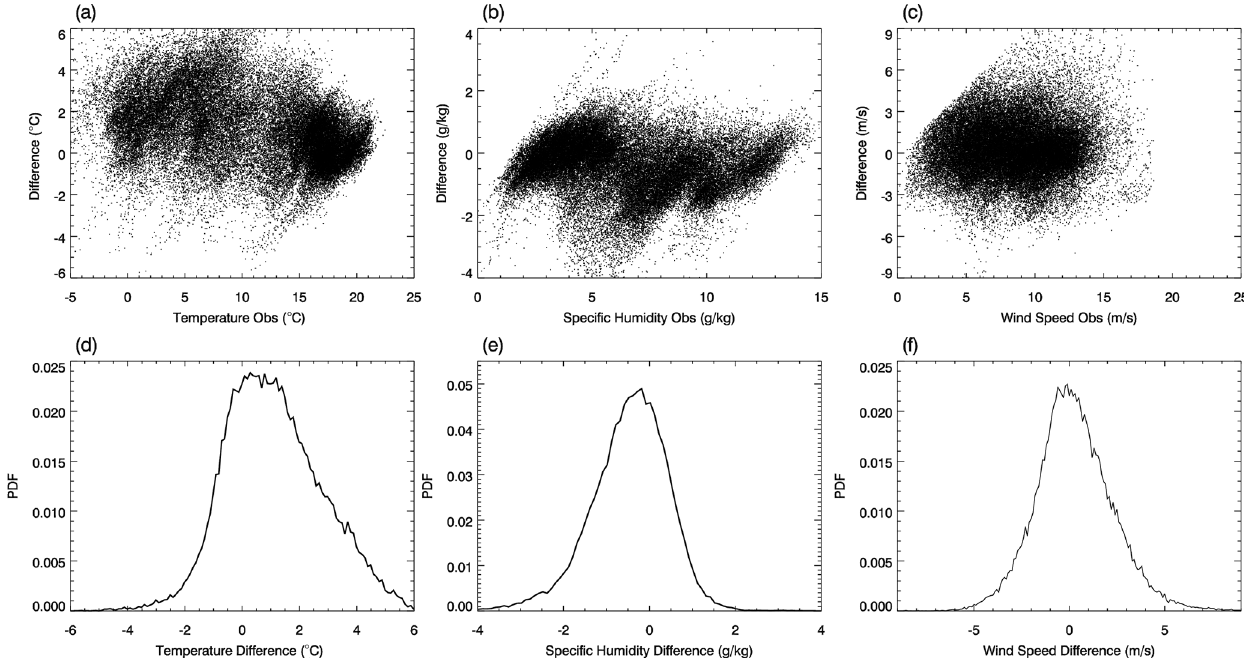
Figure 5. Scatterplot for GPM-retrieved observation vs. the departure between the observation and the model background for (a) 2m temper- ature ( ◦ C), (b) 2m specific humidity (gkg − 1 ), and (c) 10m horizontal wind speed (ms − 1 ) from all available data during the data assimilation time windows for the two case studies. The probability density function (PDF) of the (d) 2m temperature departure, (e) 2m specific humidity departure, and (f) 10m horizontal wind speed departure with a bin width of